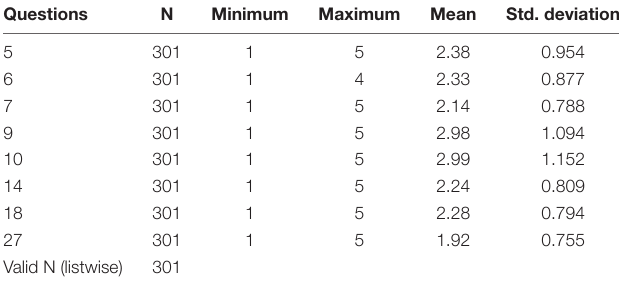
TABLE 7 | Descriptive statistics of the questions related to the learners’ motivation in technology-integrated classrooms. Questions